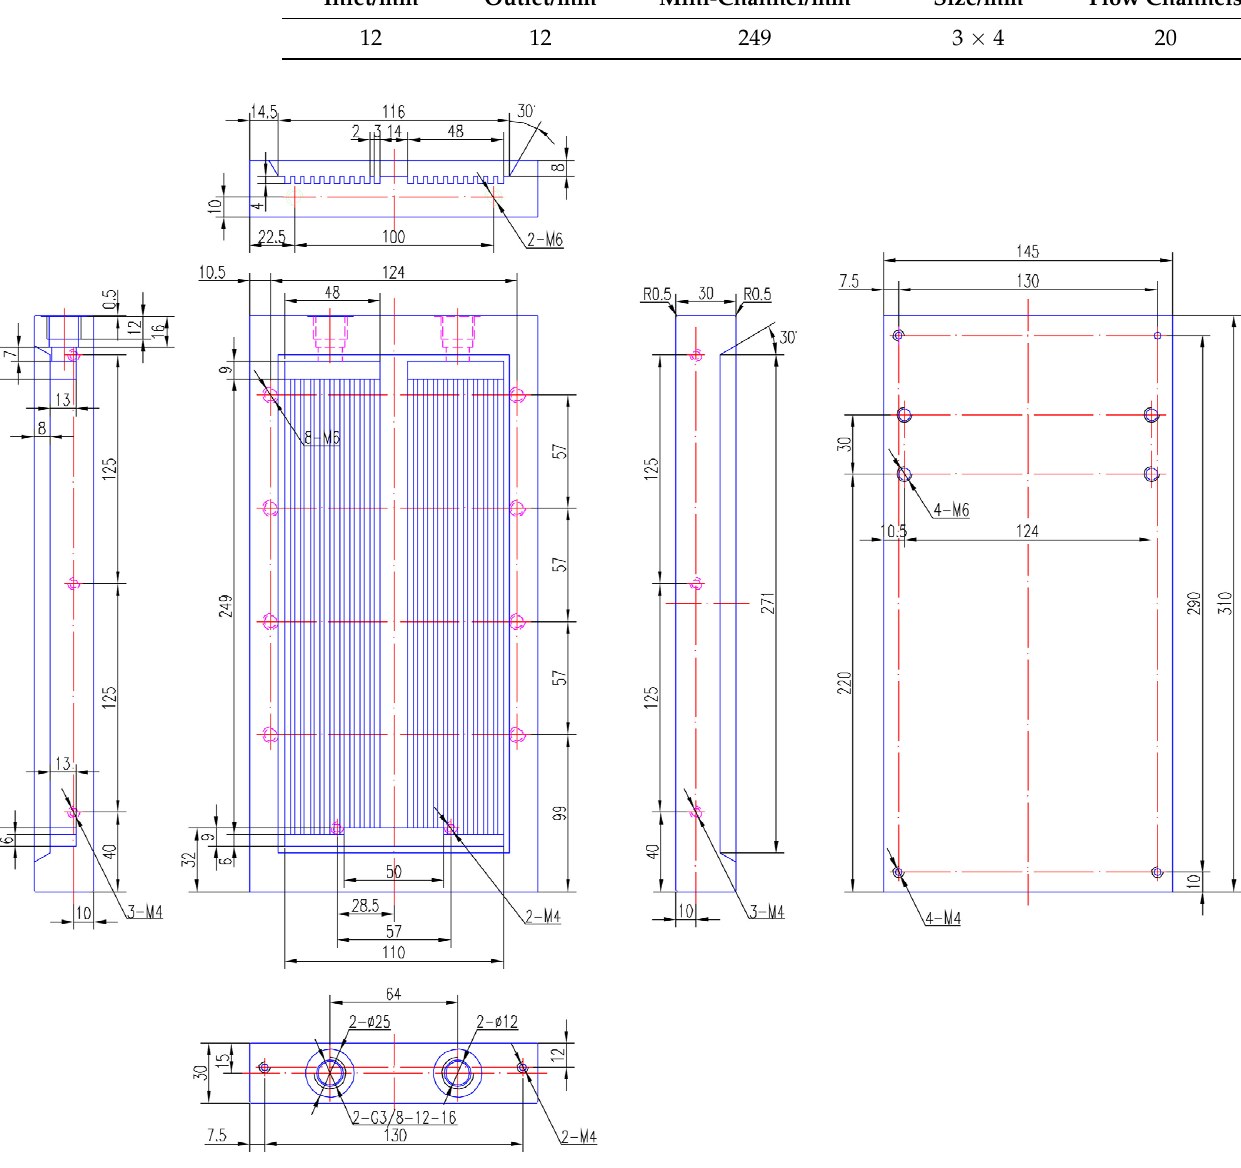
Figure 1. Structure and detailed geometric dimensions of the flat plate heat sink for IGBT cooling.